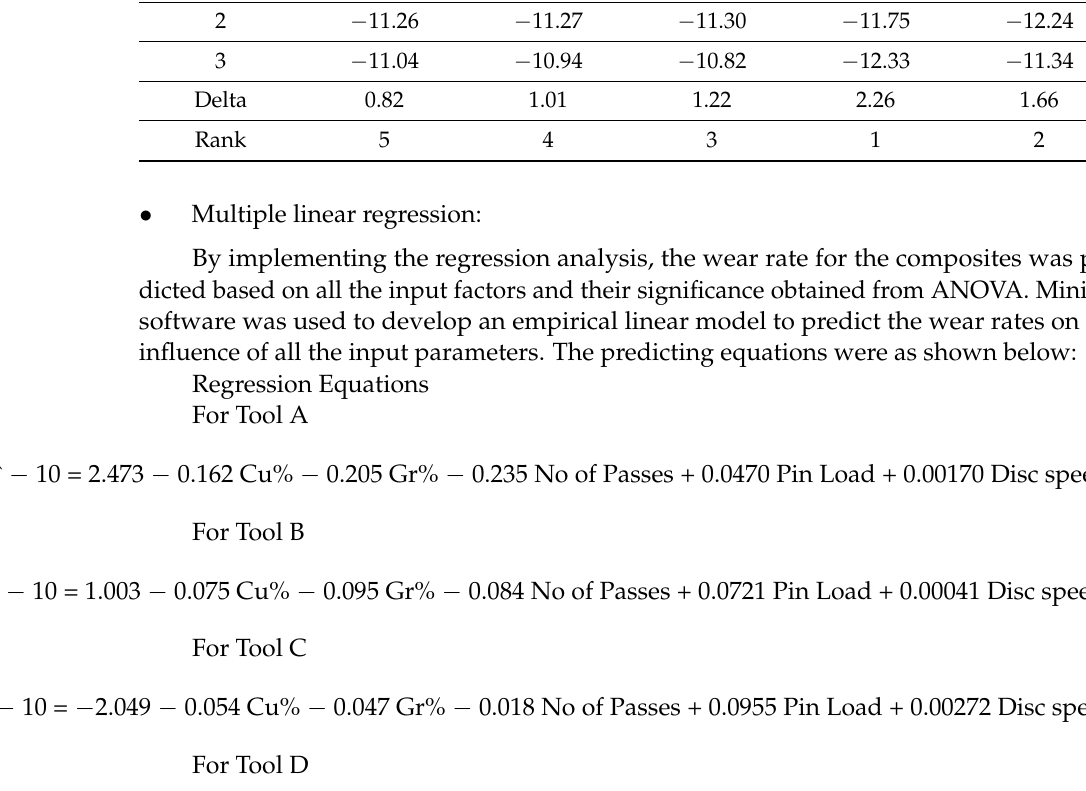
No of Pin Load Disc Speed Passes